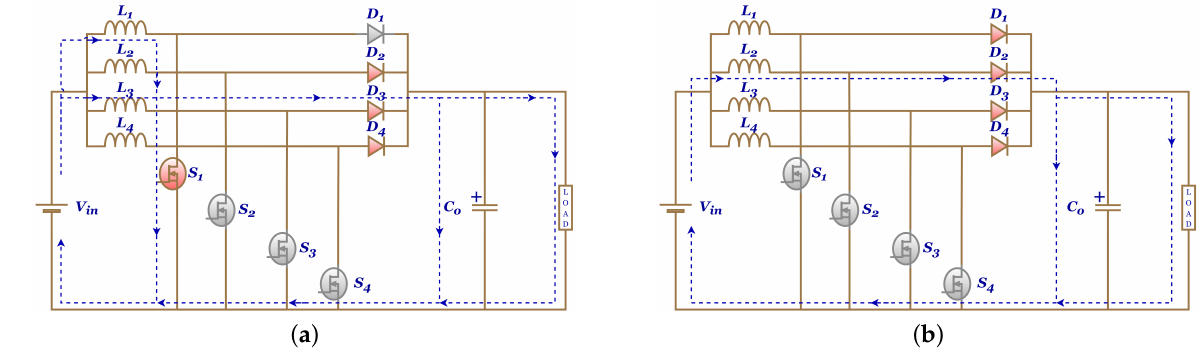
Figure 12. 4-IBC operation: ( a ) S 1 closed, and ( b ) all switches open.